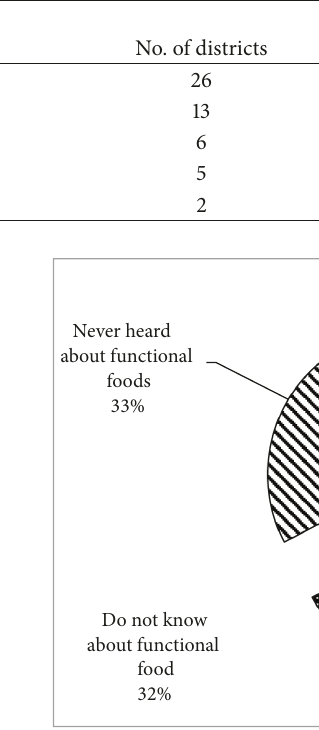
Figure 1: Consumers knowledge level about functional